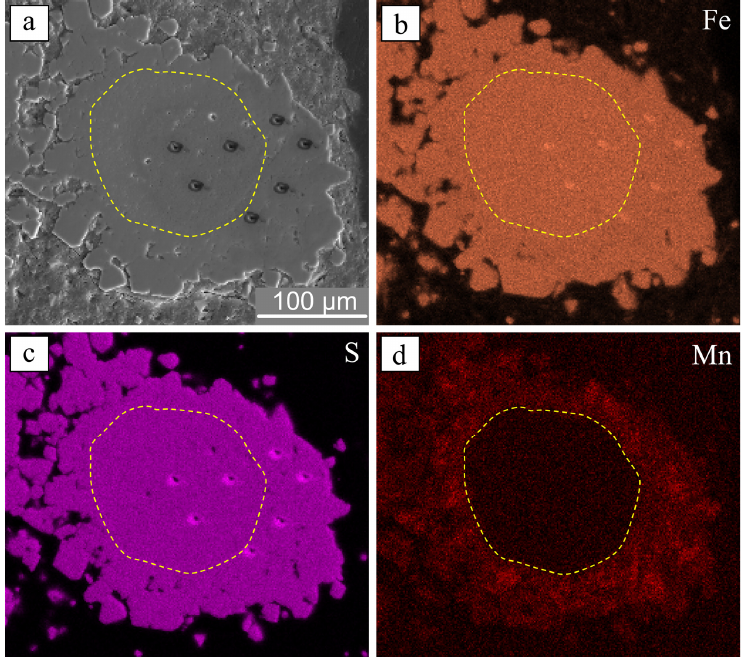
Figure 5. SEM EDS mapping results: ( a ) SEM image of aggregate of large euhedral crystals. Dark spots show SIMS analytical points; ( b ) Distribution of iron (Fe); ( c ) Distribution of sulfur (S); and ( d ) Distribution of manganese (Mn). Yellow dashed line shows the boundary between outer Mn-enriched zone and interior Mn-scarce zones.